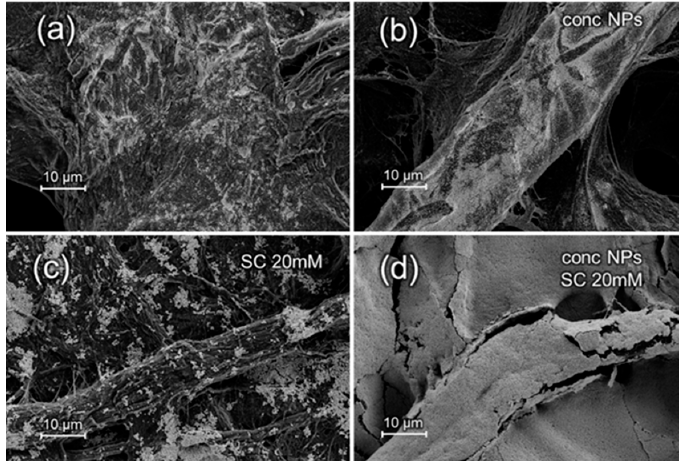
Figure 1. Field emission electron microscope (FE-SEM) images with the same magnification (5 k) of Ag nanoparticles (NPs), as prepared ( a , c ) or 10 × concentrated (“conc NPs”) ( b , d ), loaded on filter paper (average pore size: 2 m) in absence ( a , b ) or presence ( c , d ) of 20 mM sodium citrate (SC).